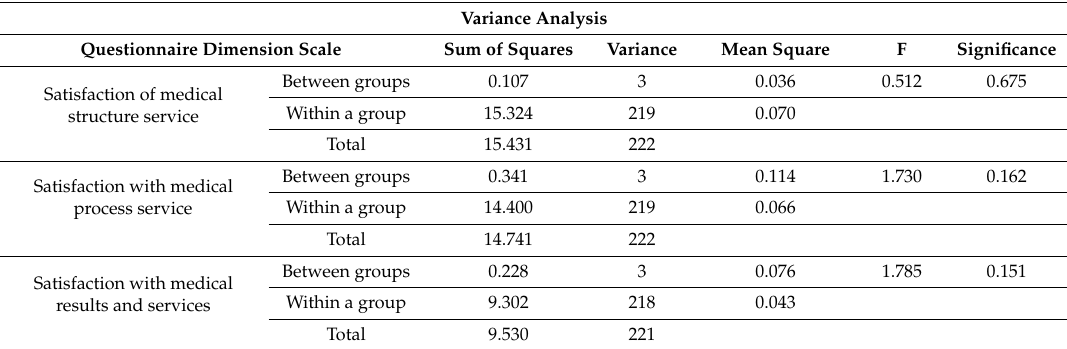
Table 22. Analysis of age and scale dimension